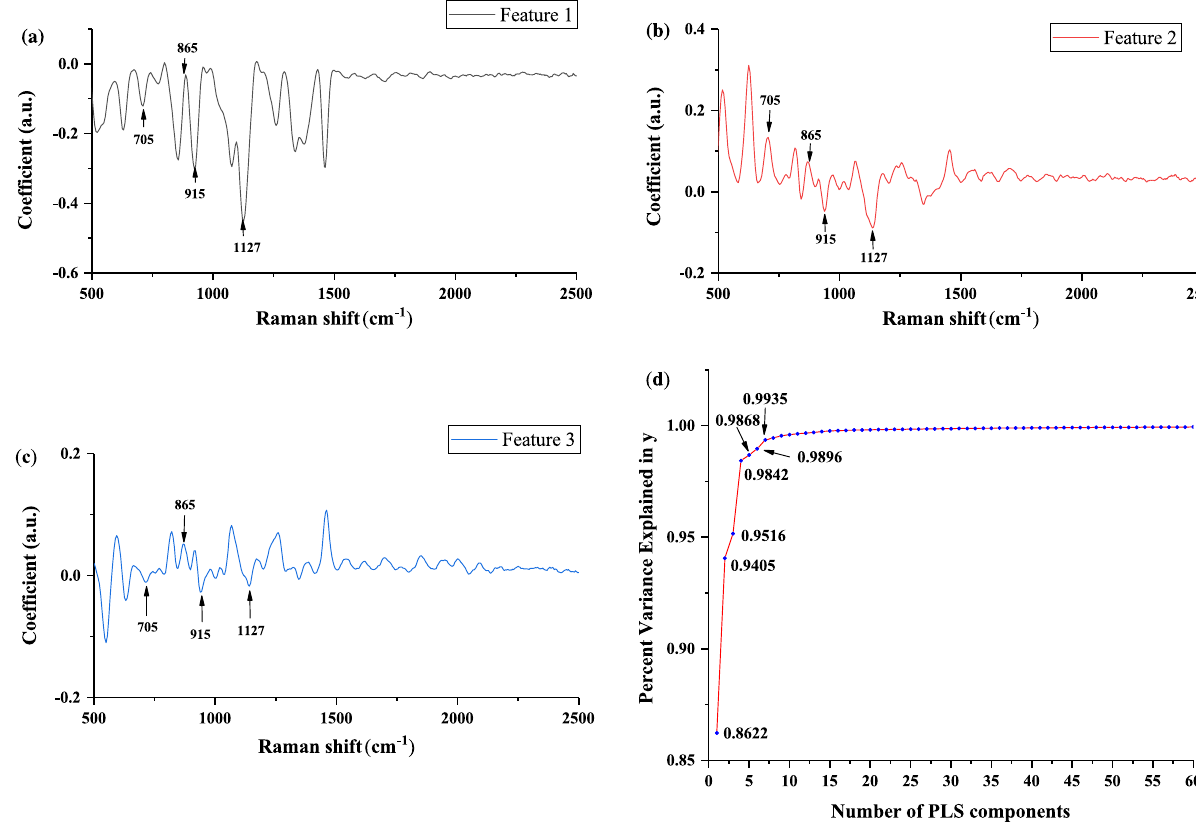
Figure 1. load curve of PLS first 3 features ( a – c ) and the feature cumulative variance explanation rate